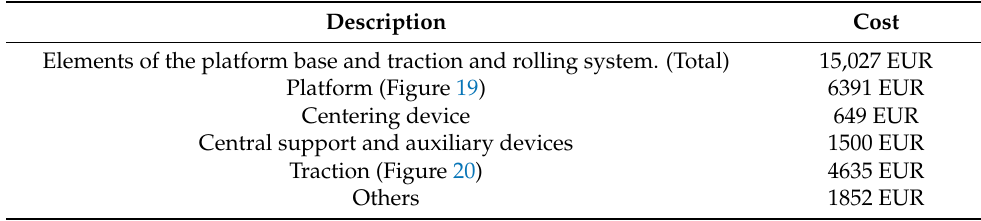
Table 3. Platform base and traction system cost.